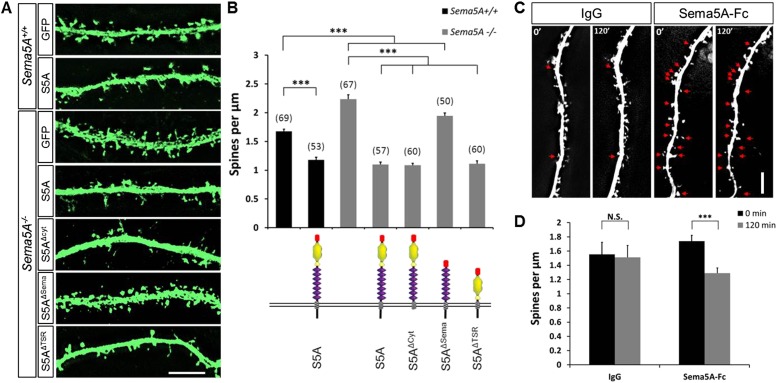
Sema5A inhibits dendritic spine density in primary dentate GCs.(A) High power deconvolution images of dendritic segments of GCs from WT (Sema5A+/+) and mutant (Sema5A−/−) hippocampal cultures transfected either with eGFP only, or eGFP plus full-length Sema5A (S5A), the Sema5A deletion constructs S5AΔcyt, S5AΔSema, or S5AΔTSR plasmid DNA. (B) Quantification of dendritic spine density of DIV21 prox1+ GCs. Numbers in brackets indicate the number of cells analyzed per condition. (C) Time-lapse study of Sema5A-Fc induced GC dendritic spine loss. DIV21 dentate cultures were treated for 120 min with Sema5A-Fc or control IgG. (D) Quantification of dendritic spine density in prox1+ GCs. Values are represented as mean ± SEM from 3 to 4 cultures, established from 3 to 4 different animals for each condition. ***p < 0.001, two-tailed unpaired Student's t test. Scale bars in A and C = 10 µm.